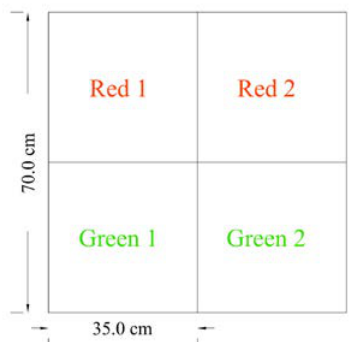
Figure 8. The project of the segment no 3: Different paint of the same colour